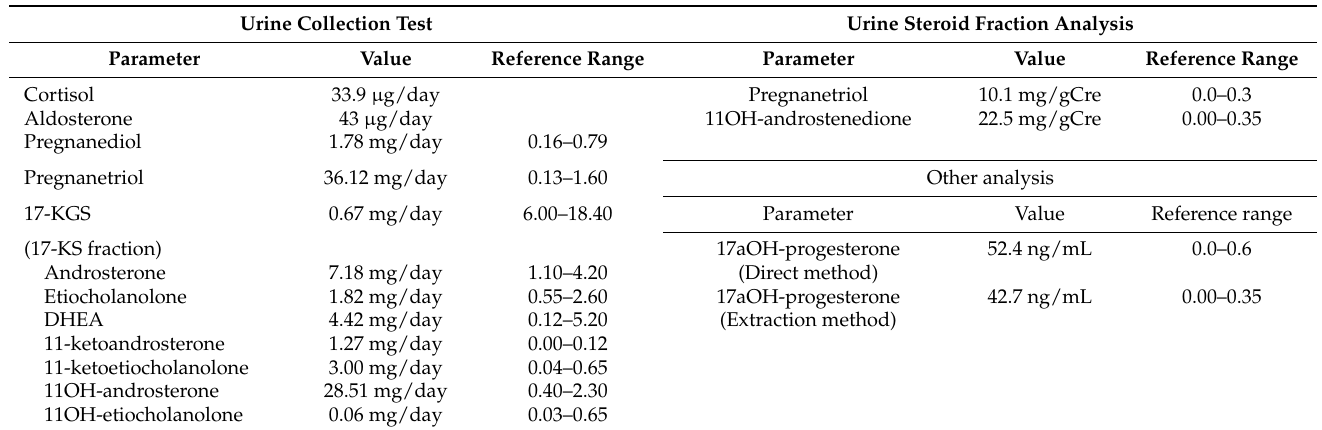
Table 3. Clinical parameters for steroid metabolism in this